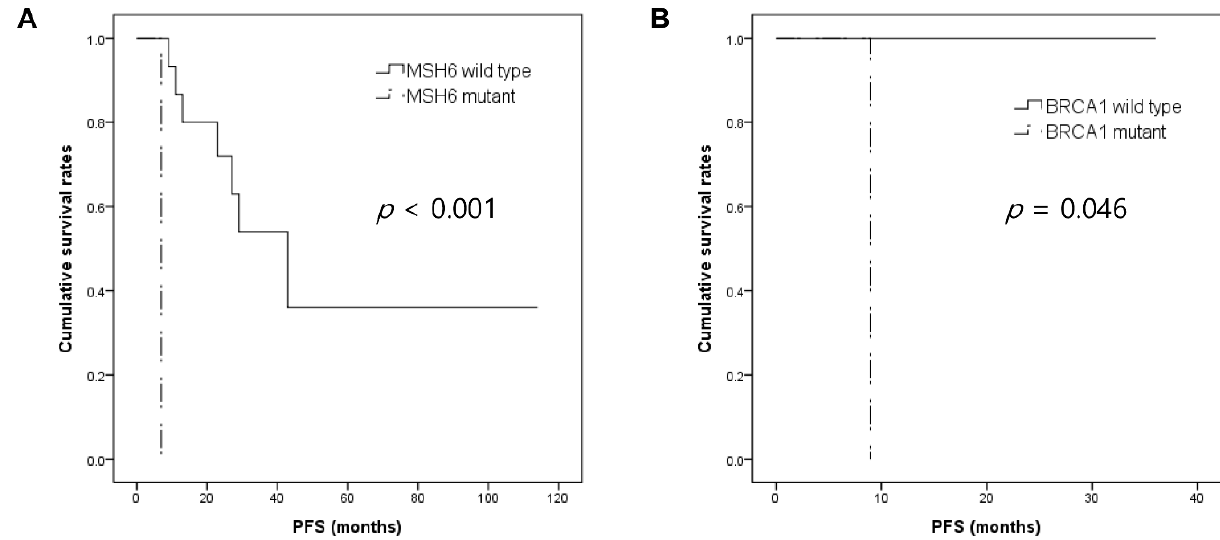
Figure 2. Kaplan–Meier analysis revealed ( A ) MSH6 mutation, and ( B ) BRCA1 mutation was associated with inferior progression-free survival in ocular and extraocular sebaceous carcinomas, respectively.